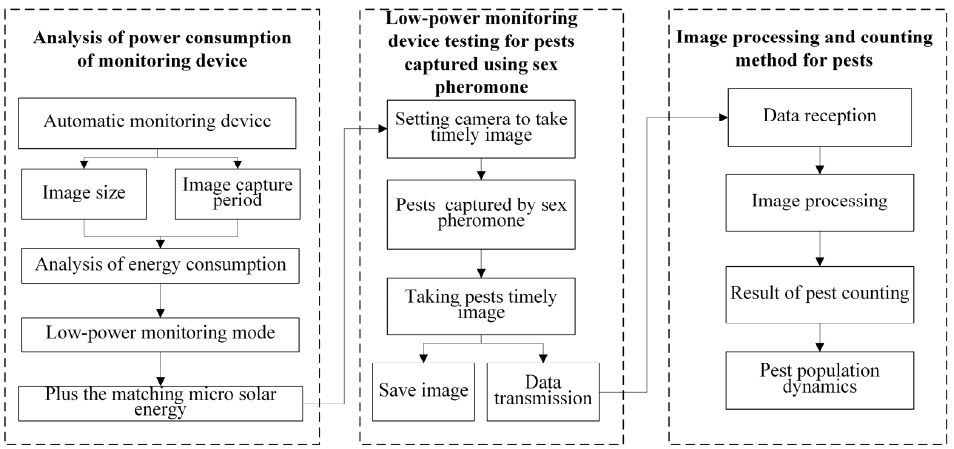
Figure 2. Frame diagram of low-power automatic monitoring system for pests captured using sex pheromone lures. pheromone